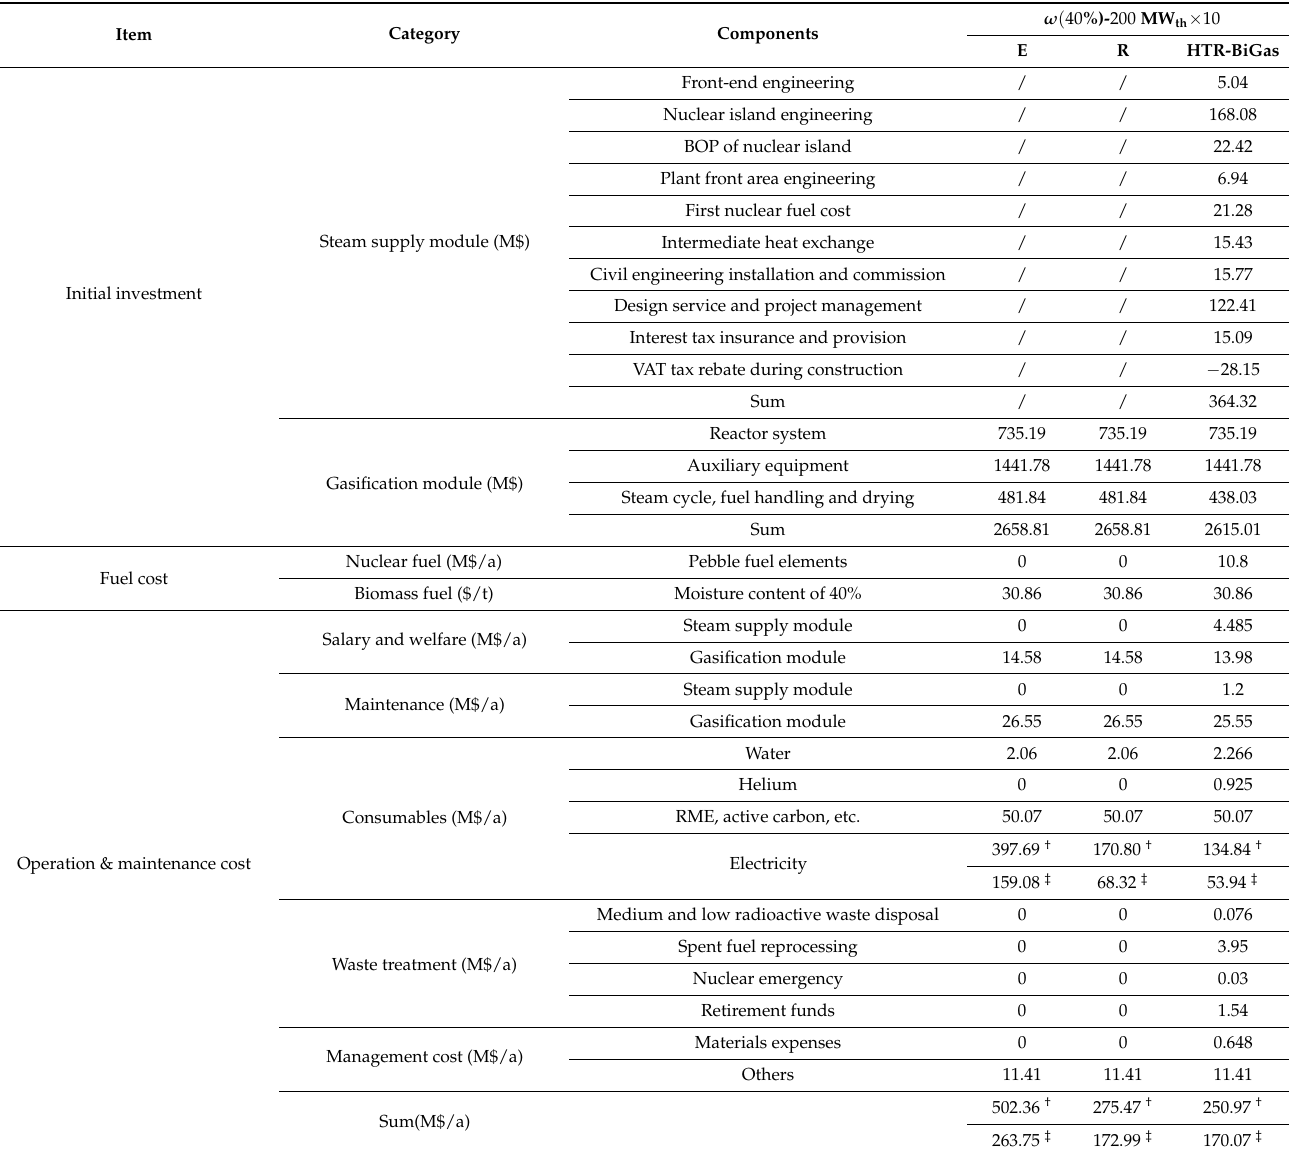
Table 7. Summary of estimated costs of different components of HTR-BiGas and other